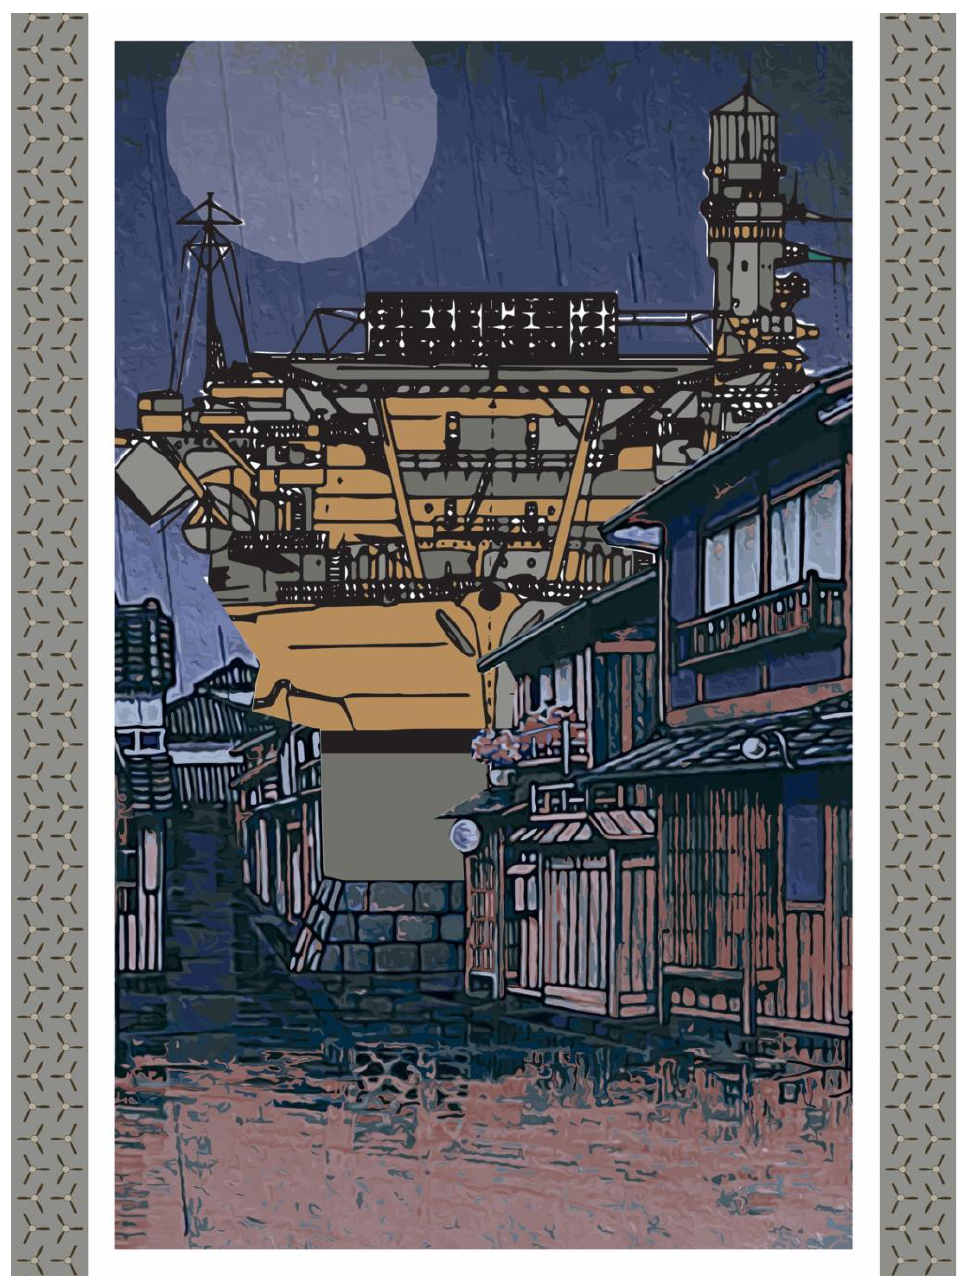
Kio Griffith, Eight Views of the Sun Setting on the South Pacific / The Bridge , 2021. Digital collage print on